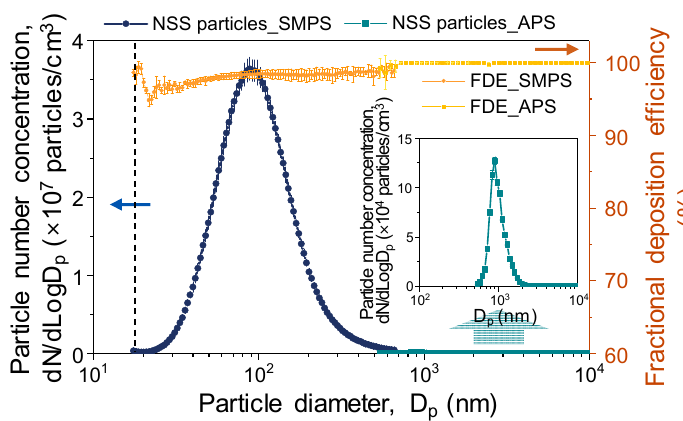
Figure 2. Particle size distribution of natural sea salt (NSS) particles measured by a scanning mobility particle sizer (SMPS) and an aerodynamic particle sizer (APS), with fractional deposition efficiency (FDE) of the control filter. Error bars indicate the standard deviation ( n = 3).